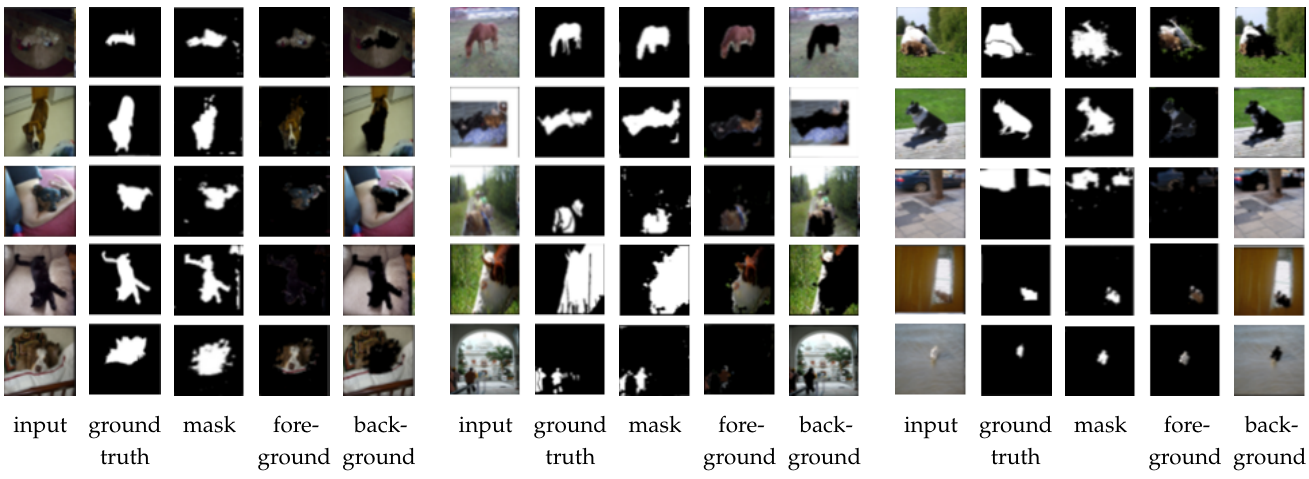
Figure 6. The segmentation results with PascalVOC dataset. In each group, the first column is the input image, the second column is the ground truth binary mask, the third column is the generated binary mask by our Mumford–Shah network, the fourth column is the foreground region, and the fifth column is the background region calculated by the generated binary